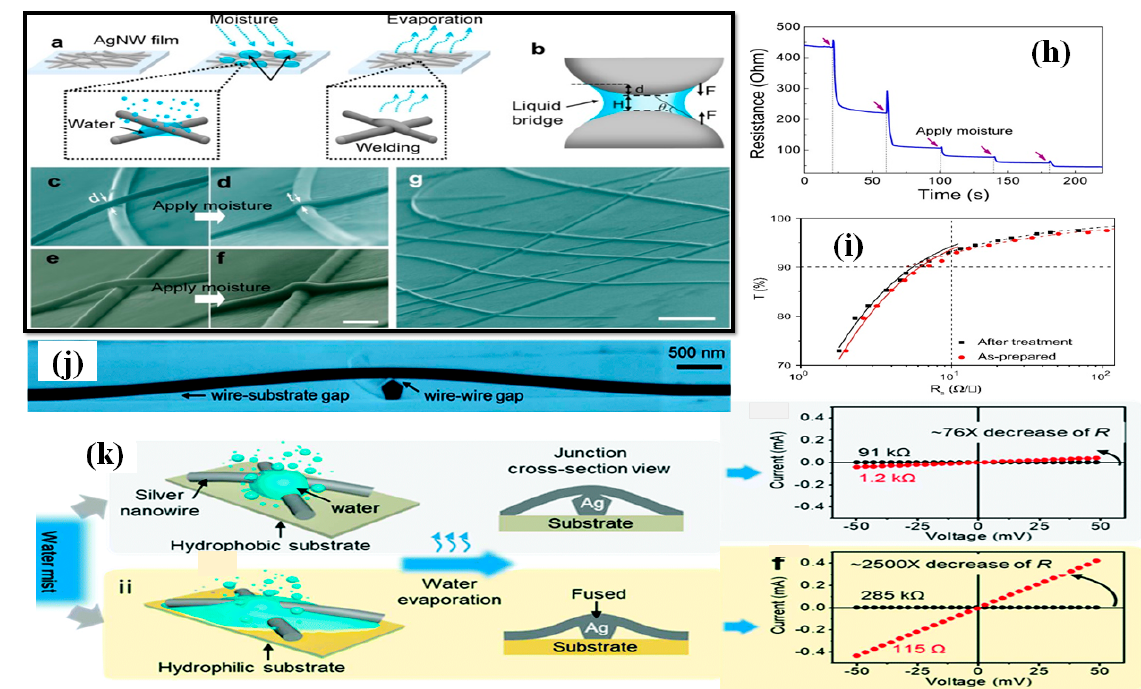
Figure 20. Capillary-force-induced cold welding of AgNWs. ( a ) Schematic of moisture treatment for capillary-force-induced cold welding of AgNWs. ( b ) Schematic of the mechanism of capillary interaction between two particles connected with a liquid bridge. ( c – f ) Two sets of SEM images of Ag wire-wire junctions before and after moisture treatment. Scale bar: 200 nm. ( g ) SEM image of a relatively large area of AgNWs showing well welded wire-wire junctions and relatively smooth surface caused by the moisture treatment. Scale bar: 1 µm ( h ) Resistance of a AgNW film significantly decreases after moisture treatment for a few cycles (adapted from [232] with permission from ACS publications, 2017). ( i ) A Plot of T versus log R s for the AgNW-based TEs (adapted from [125] with permission from Elsevier, 2018). ( j ) SEM image of an AgNW wire–wire junction on a plain substrate. ( k )) Illustration of the water-mist treatment process on different substrates for cold-welding) I-V curves of the AgNW junctions before (black dots) and after (red dots) water-mist treatment on hydrophilic glass (bottom) and hydrophobic PET (up) (adapted from [233] with permission from Royal Society of Chemistry, 2018).